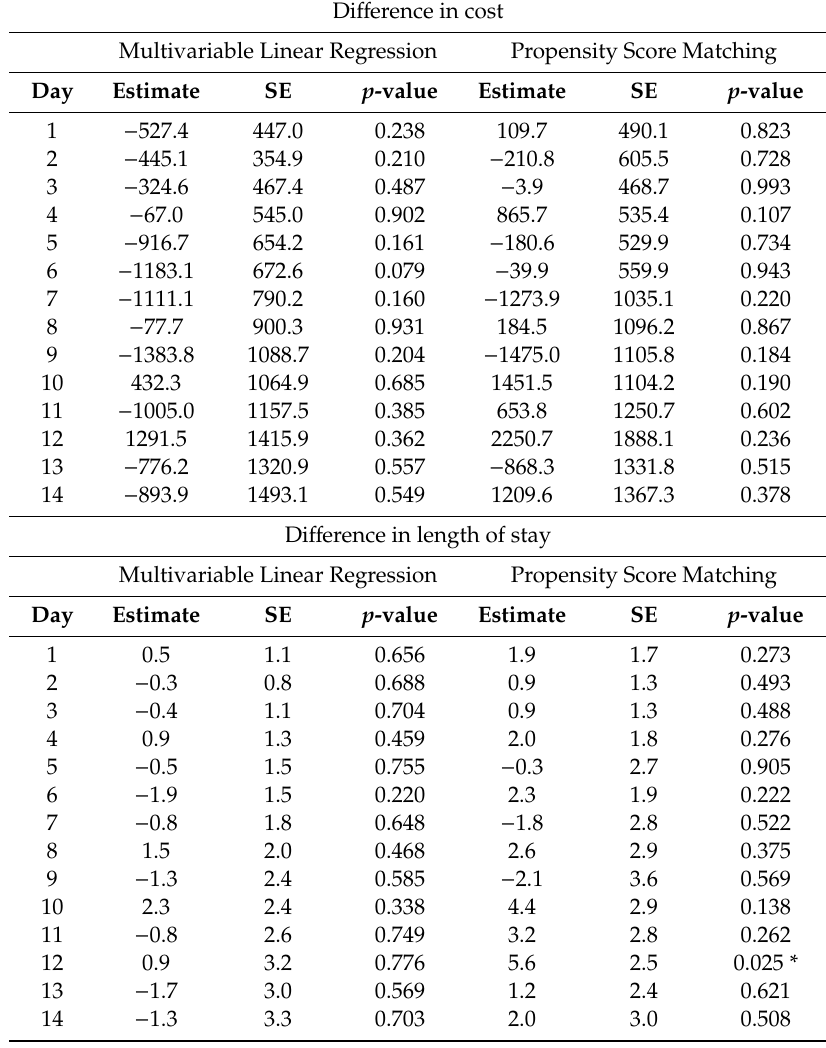
Table 4. Di ff erences in cost and length of stay for fall events (reference: without